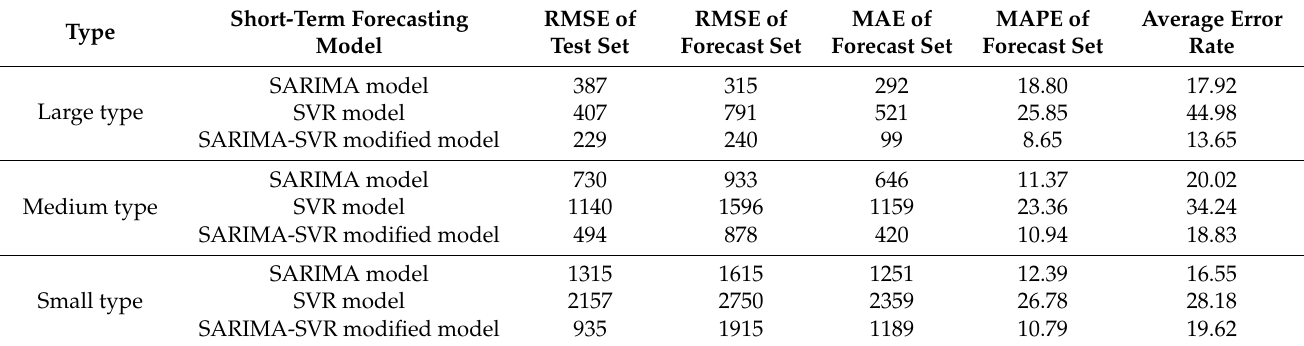
Table 7. Prediction results of the SARIMA model and SVR–SARIMA modified